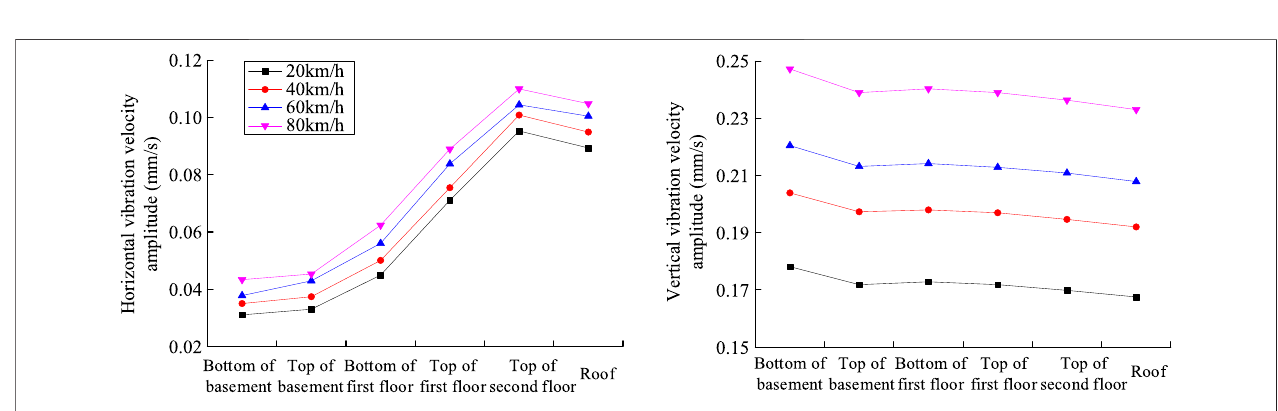
FIGURE 7 | The amplitude of vibration velocity at different parts of the Drum Tower.